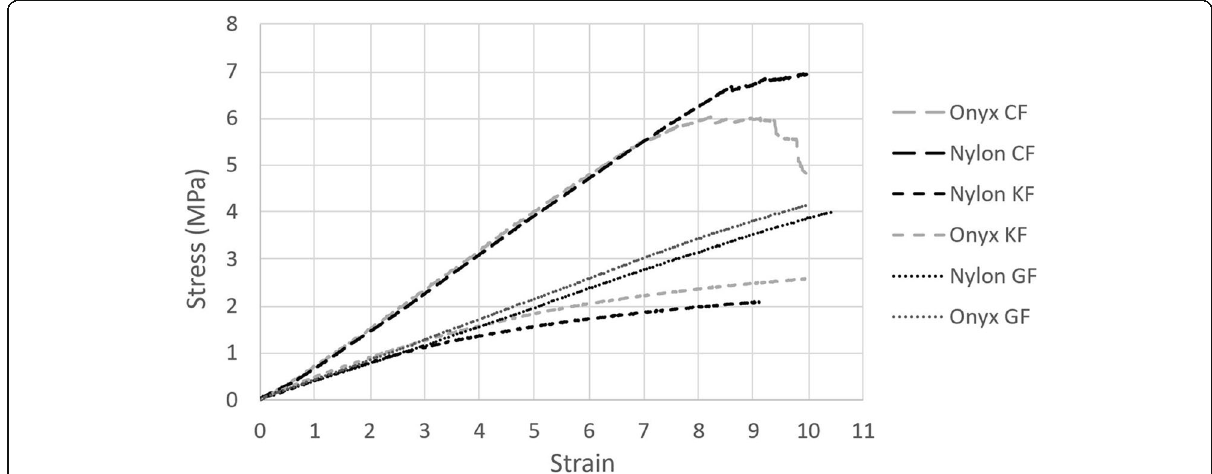
Fig. 8 Flexural Stress-Strain Curves for Highest Performing Composites (12 layers, 0,90